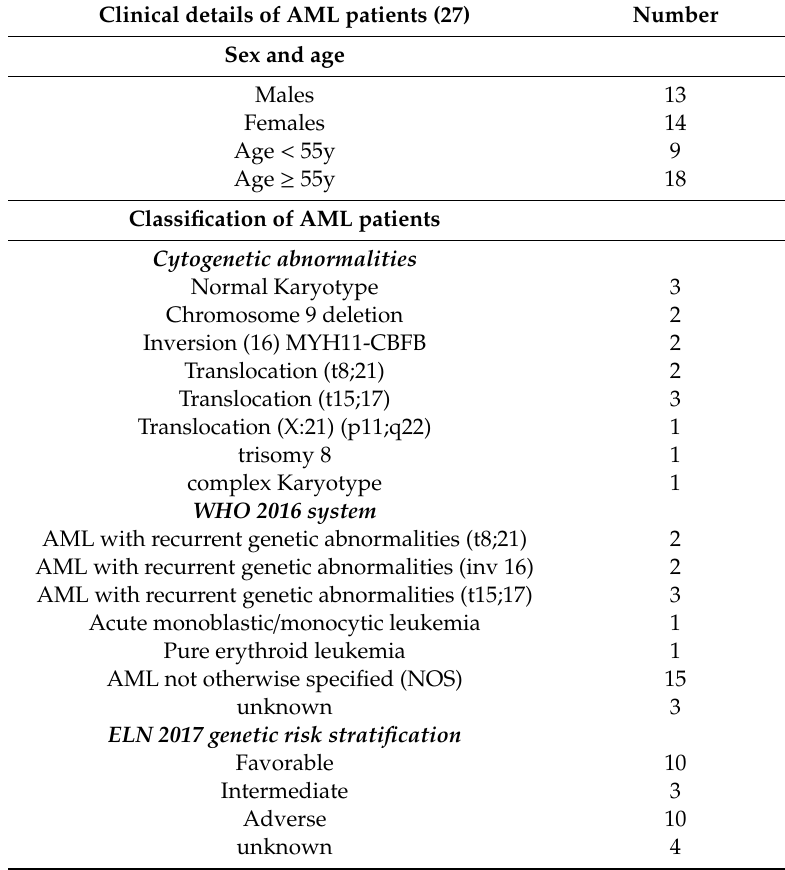
Table 1. Summary of acute myeloid leukemia (AML) patient clinical details used for the